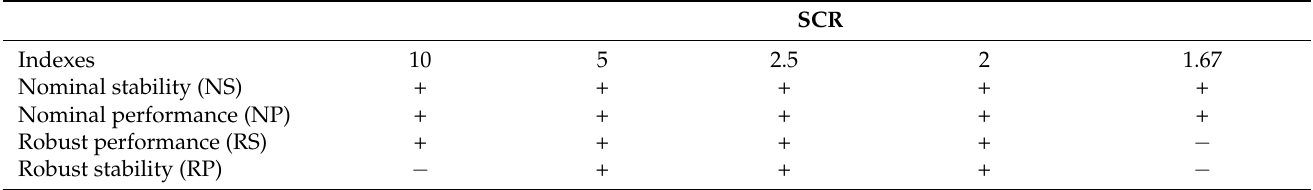
Table 4. Nominal and robust stability and performance comparison for different grid SCRs ( P = P n